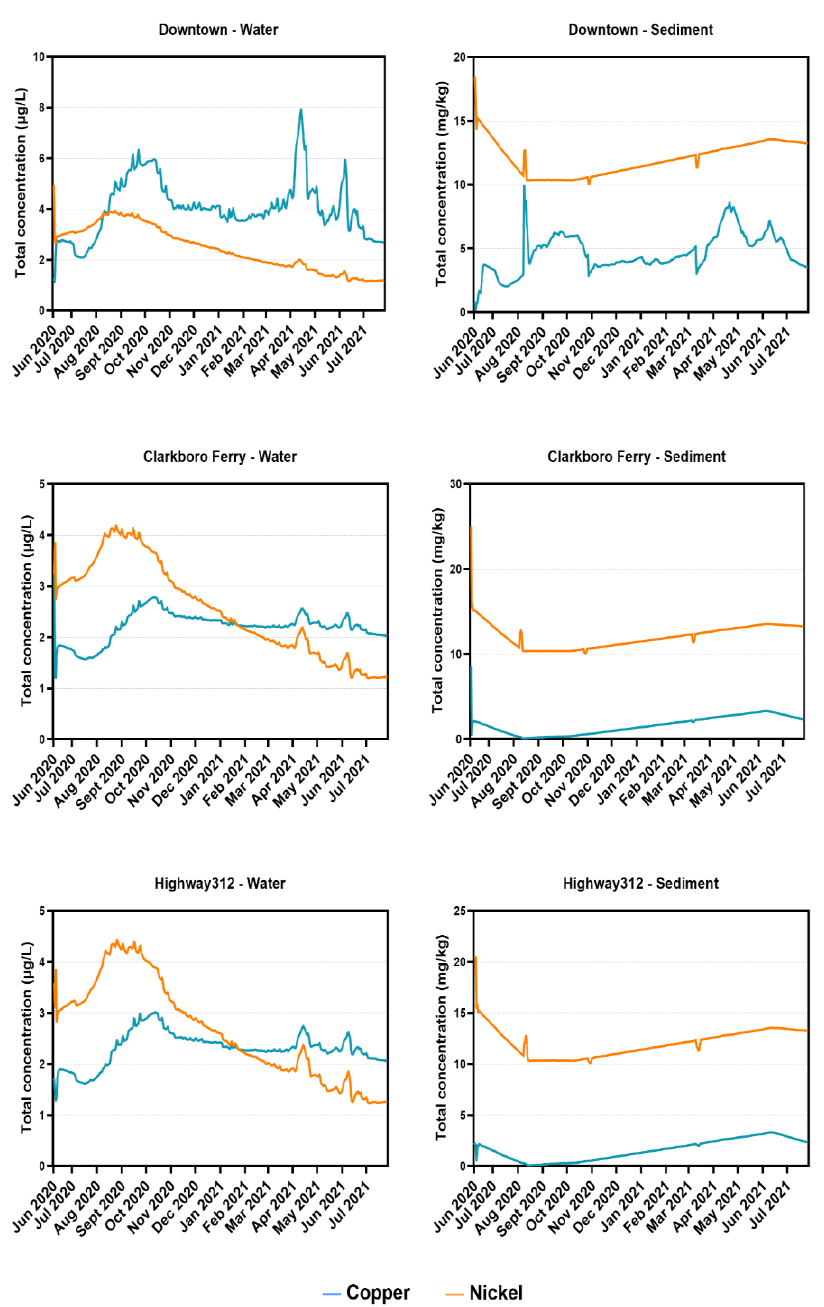
Figure 4. Concentrations of Cu and Ni in water and sediment for selected sites during the 2020 and 2021 field seasons.